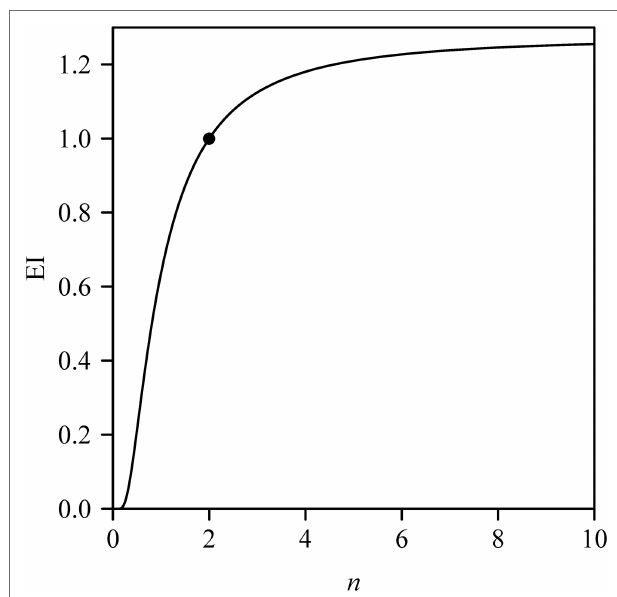
FIGURE 7 | Leaf ellipticalness index (EI) varying with the n values in the superellipse. The point corresponds to the EI when n =